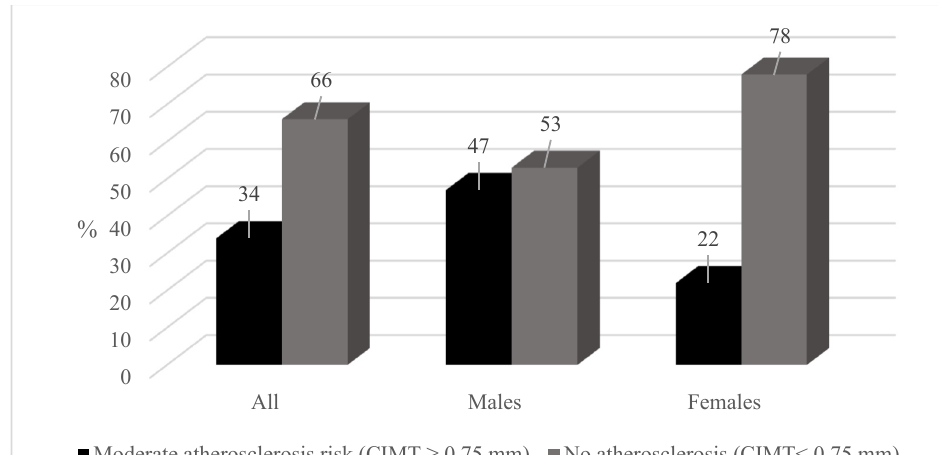
Figure 4. Percentage (%) scores for CIMT. Table 2. Differences in descriptive characteristics of the teachers according to waist circumference